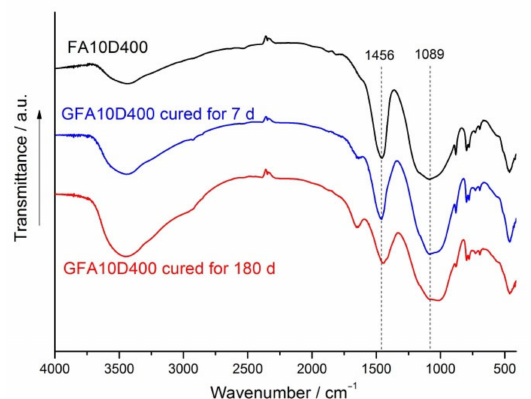
Figure 11. FTIR spectra of the 90% FA + 10% dolomite blend milled for 400 s (FA10D400) and the geopolymer based on this blend (GFA10D400) cured for 7 and 180